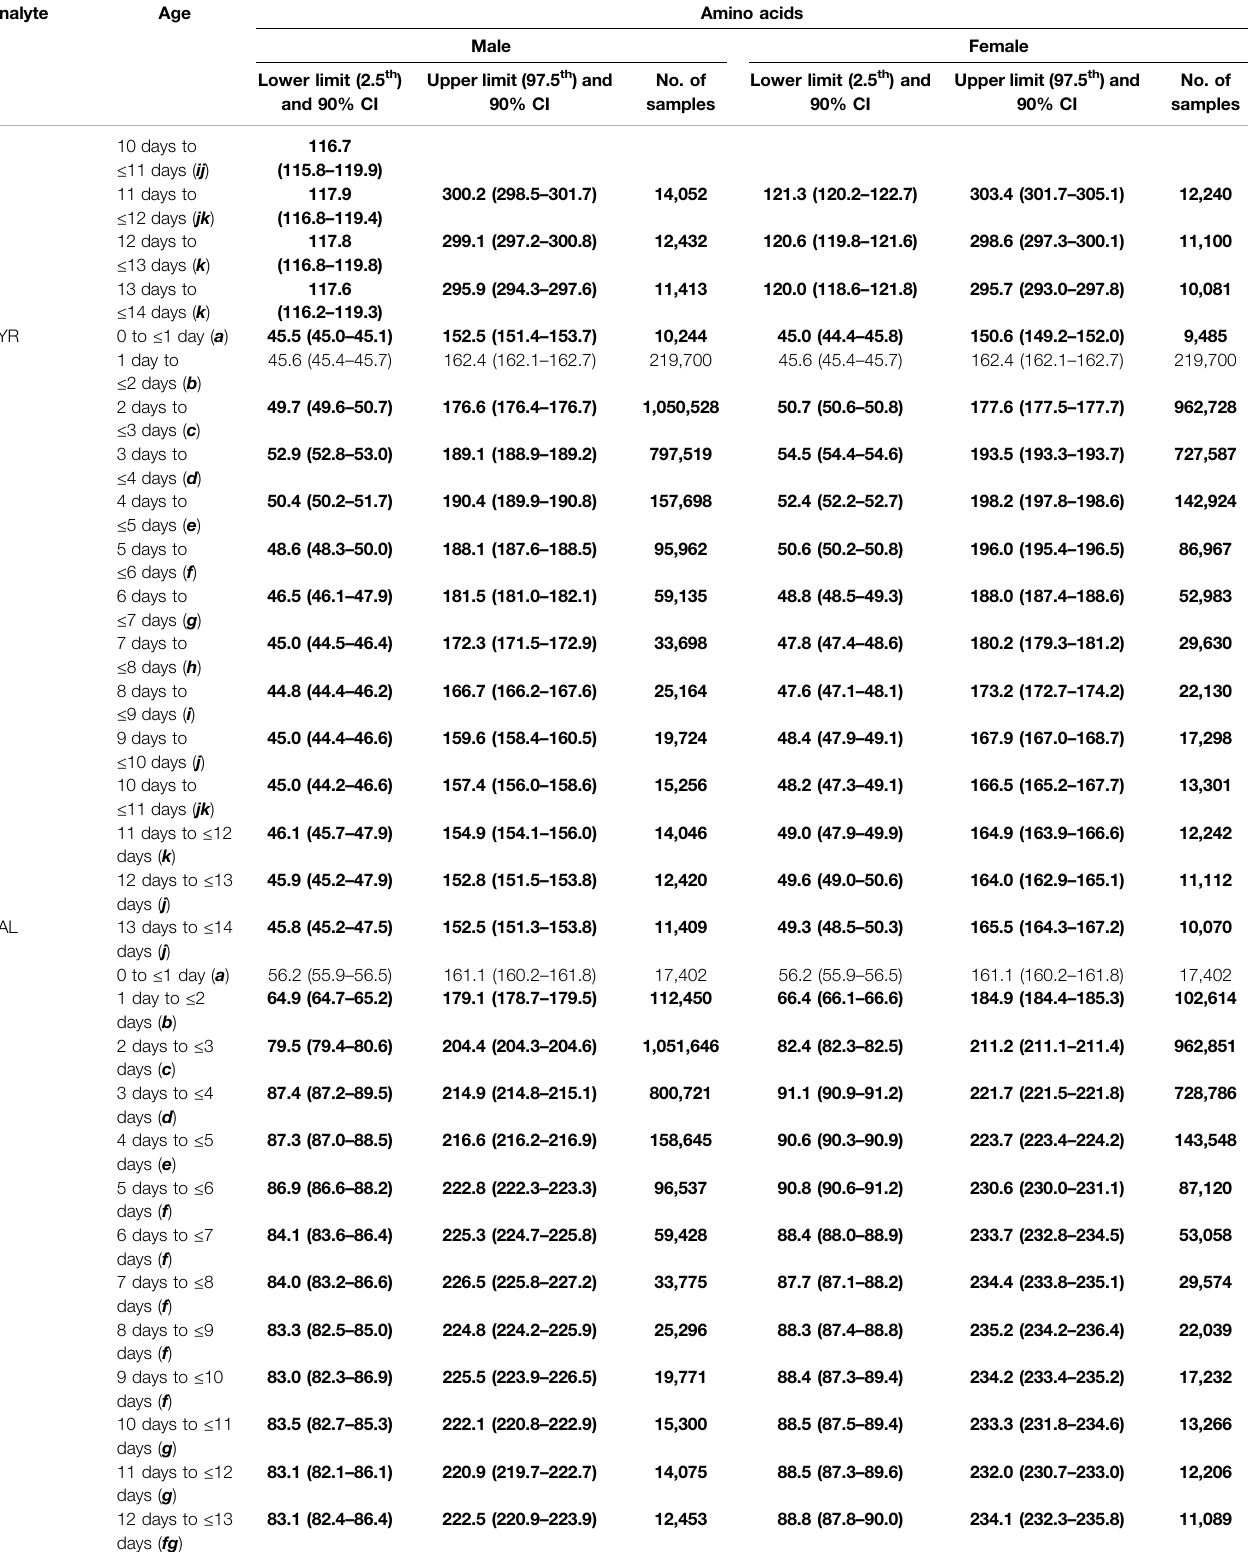
TABLE 2 | ( Continued ) The Reference intervals partitioned by each day and sex for 35 MS/MS NBS biomarkers ( μ